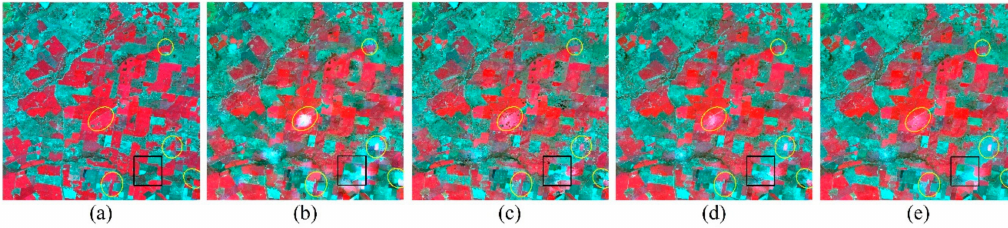
Figure 4. Visual comparison of the predicted Landsat-like images by STARFM, STRUM, FSDAF, and EFSDAF in dataset 1 (vegetation phenology). From left to right, green-red-NIR (standard false color) composites of ( a ) a true Landsat image of 6 August 2004; ( b – e ) predicted images of 6 August 2004 by STARFM, STRUM, FSDAF, and EFSDAF, respectively. (Figure 4 shows the predicted Landsat-like images of 6 August 2004 by four fusion methods in gradual change area, and the yellow elliptical circles represent the intuitive di ff erences of the four fusion methods. The zoom-in black square areas marked in Figure 4 are used to visually evaluate the performance of the four methods for the vegetation phenology in heterogeneous regions (Figure 5)).